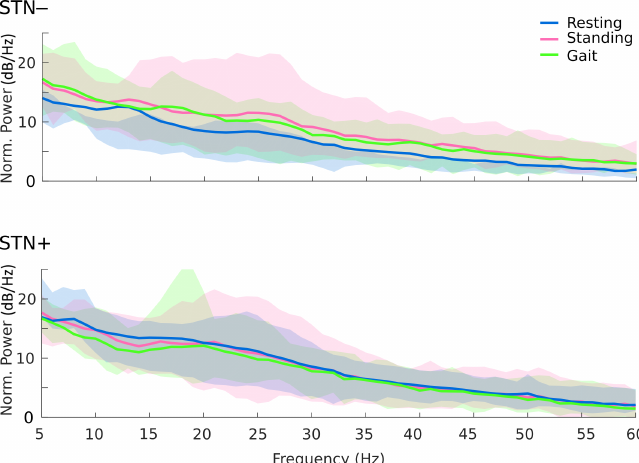
Fig 1. Spectral profiles (average) during resting, upright standing, and gait. Average spectral power of the STN local field potential during resting (blue line), standing (pink line) and gait (green line) for the two hemispheres, with less (–) and more (+) striatal dopamine innervation. Results are corrected for the nominal noise floor level of the device (150nV/rtHz, [32,33]), all values above 0dB/Hz are reliable. Shaded areas represent the confidence intervals (5– 95%) of the group mean. The peak at 32 Hz is a known artefact of the Activa PC+S 1 system tied to clock settings or due to a triggered check of the battery